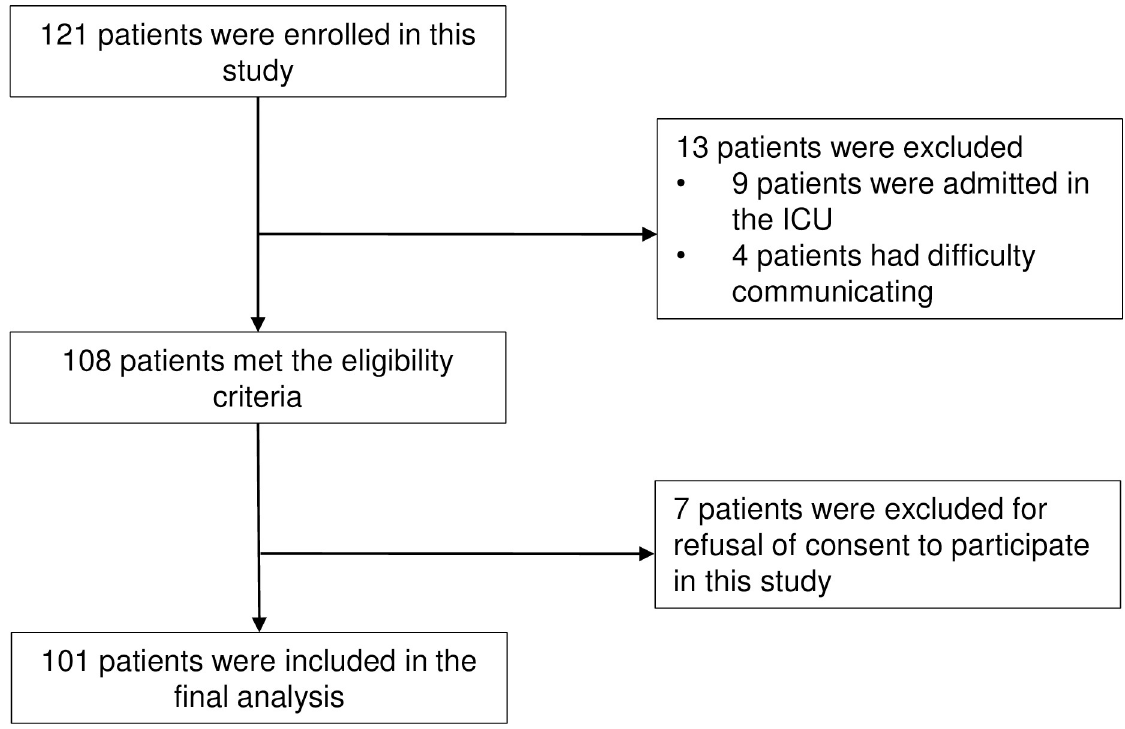
Fig 1. Patient enrollment